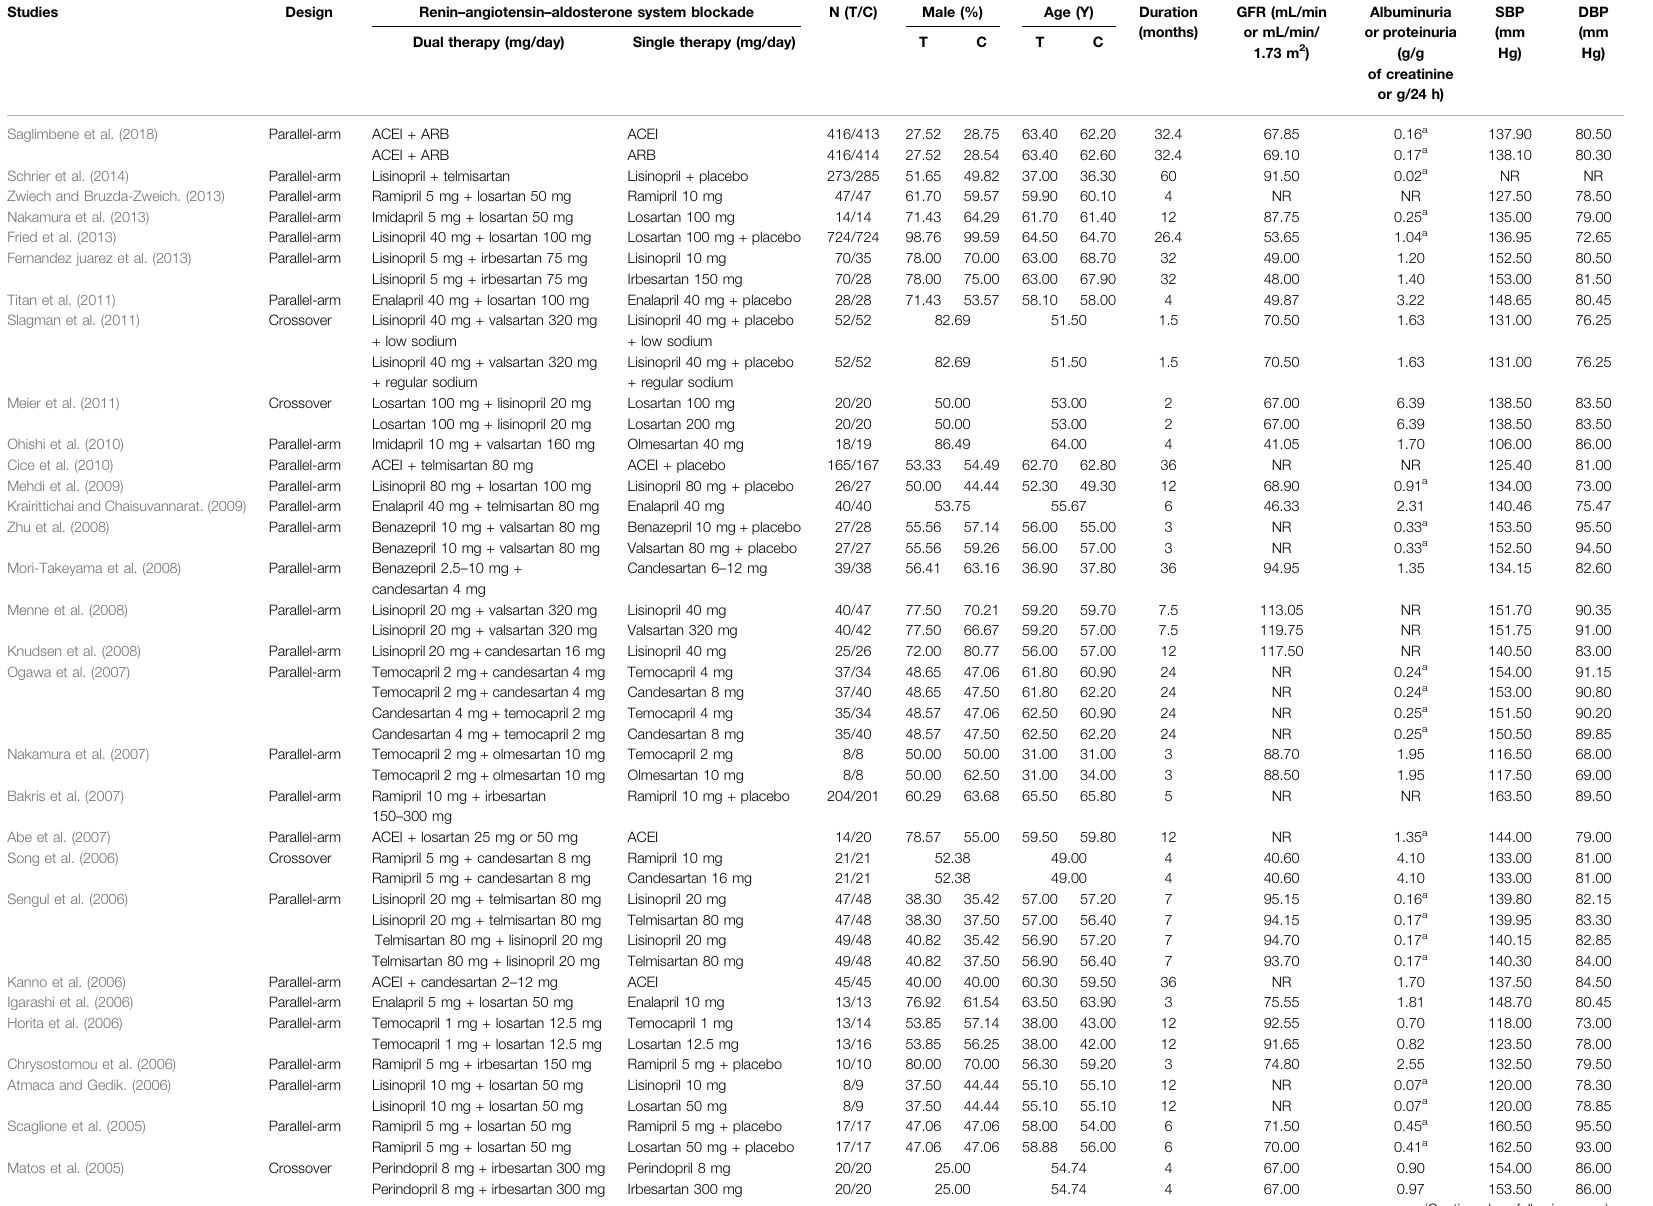
TABLE 1 | Characteristics of randomized controlled trials included in this